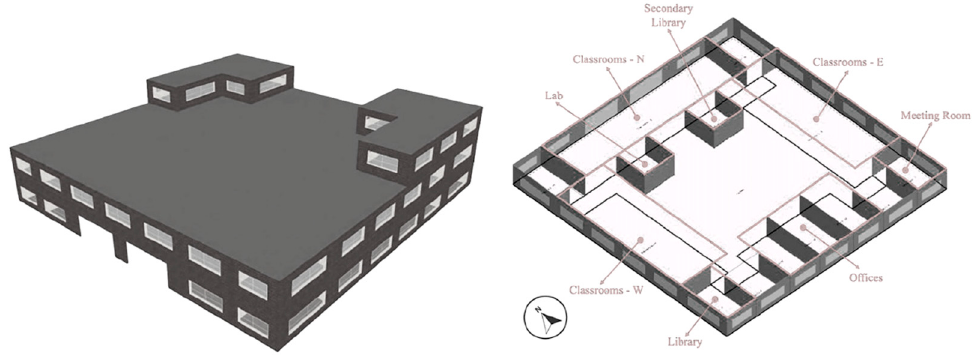
Figure 1. 3-D renderings of the prototypical school building energy model including a floorplan Figure 1. 3 ‐ D renderings of the prototypical school building energy model including a fl oorplan layout developed using layout developed using DesignBuilder.